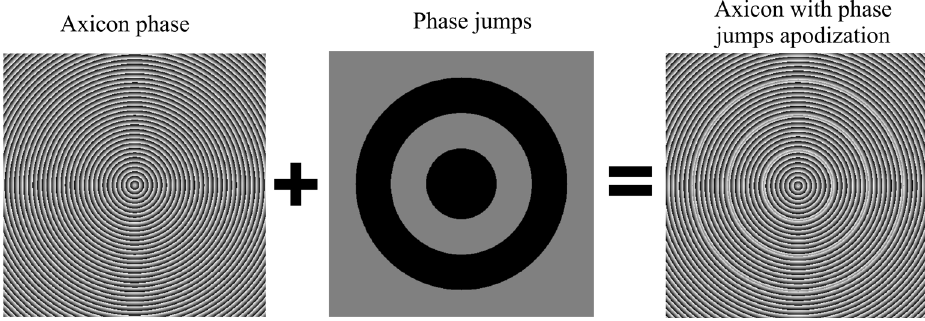
Figure 8. Illustration of axicon apodization by phase jumps ( π -shifts between black and grey). The element defined by Equation (22) provides zero intensity on the optical axis at points z q = r qs /α due to the arrival of rays in the antiphase. Figure 9 shows the results of modeling the formation of three optical bottles on the optical axis.